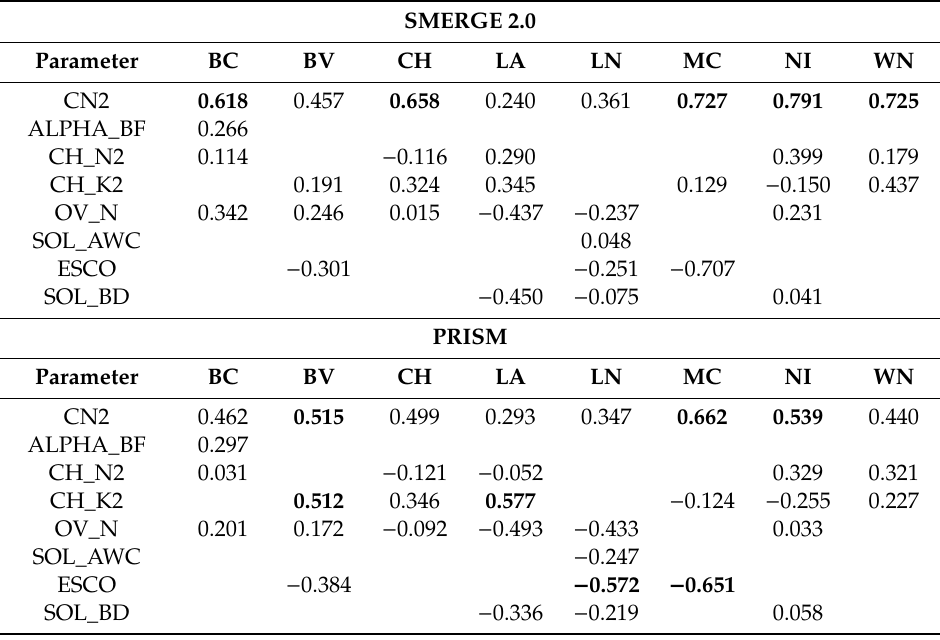
Table 7. Parameter correlation (r) versus PRISM precipitation and SMERGE 2.0 root zone soil moisture anomalies based on individual year (1992 to 2015) runs.